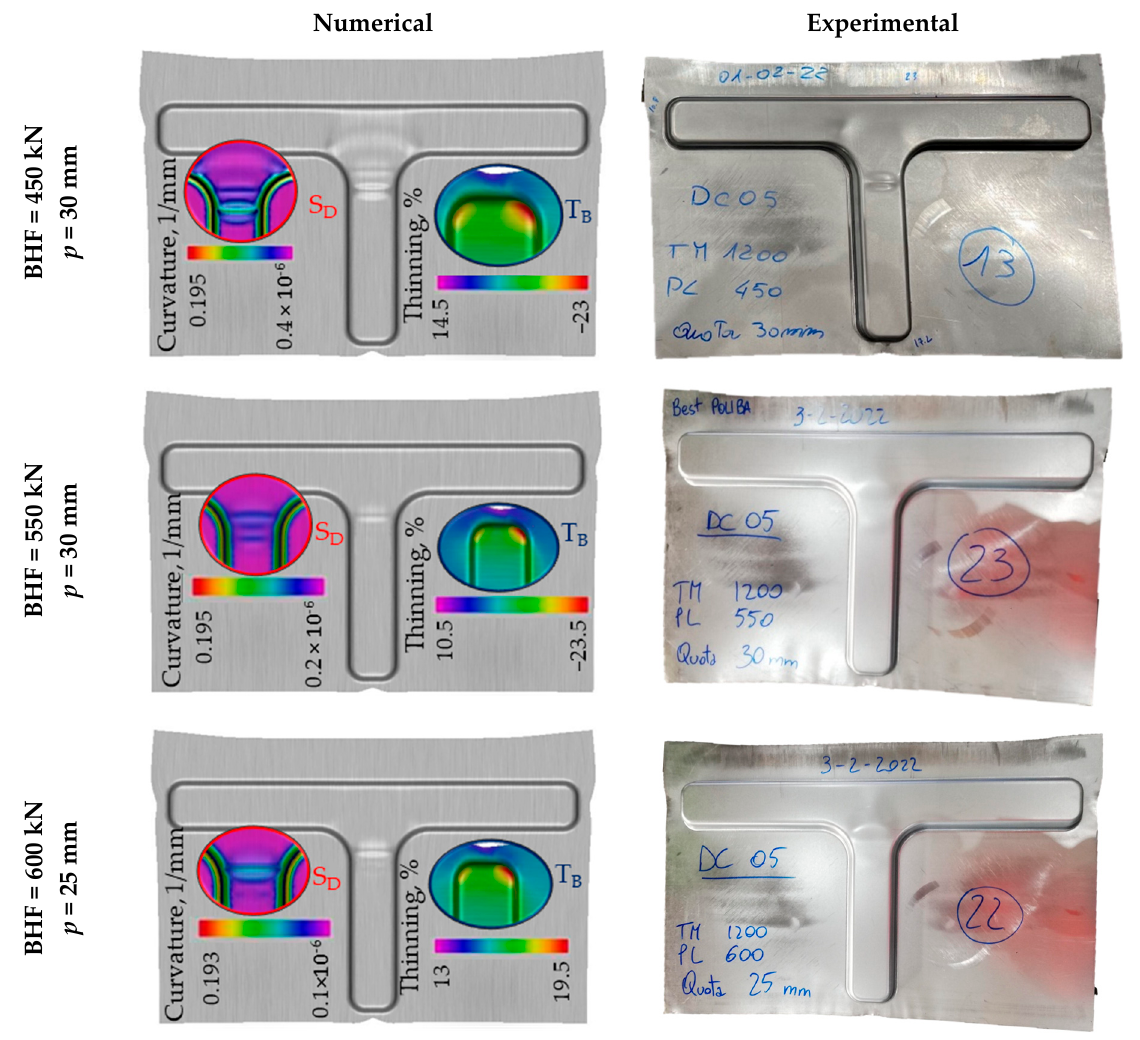
Figure 8. Numerical–experimental comparison of the drawn component for different values of BHF and p .